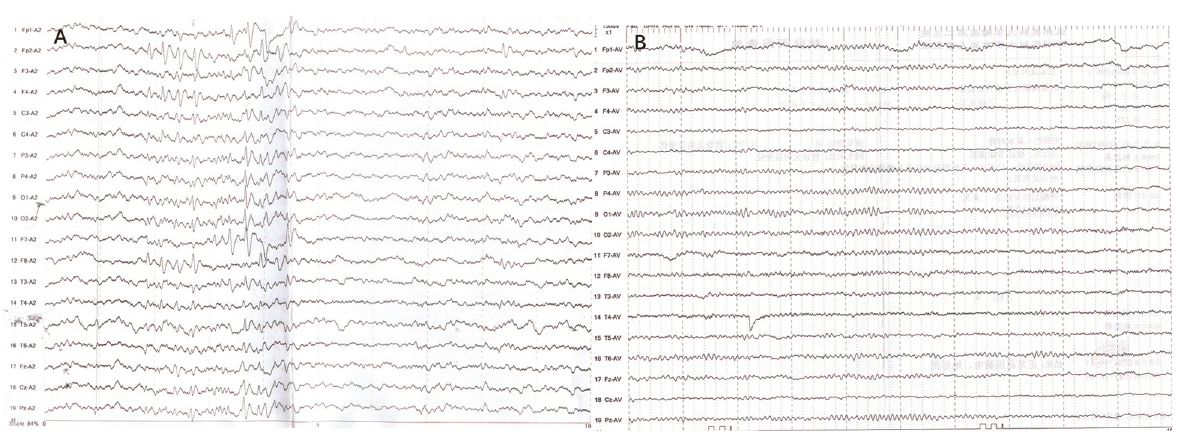
FIGURE 1 EEGs for this patients. ( A ) sharp waves and slow waves could be detected in each brain area which are predominant in anterior head lead. ( B ) EEG became normal during follow